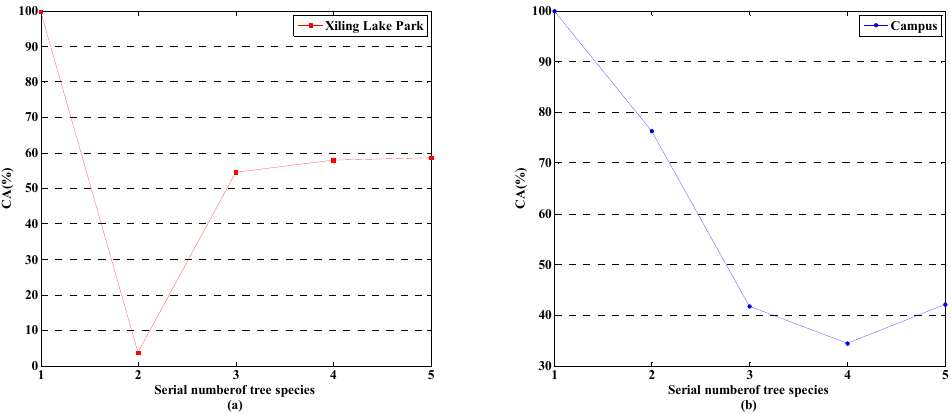
Figure 12. Class accuracy (%) of ( a ) samples from campus classifying samples from Xiling Lake Park, and ( b ) samples from Xiling Lake Park classifying samples from campus.